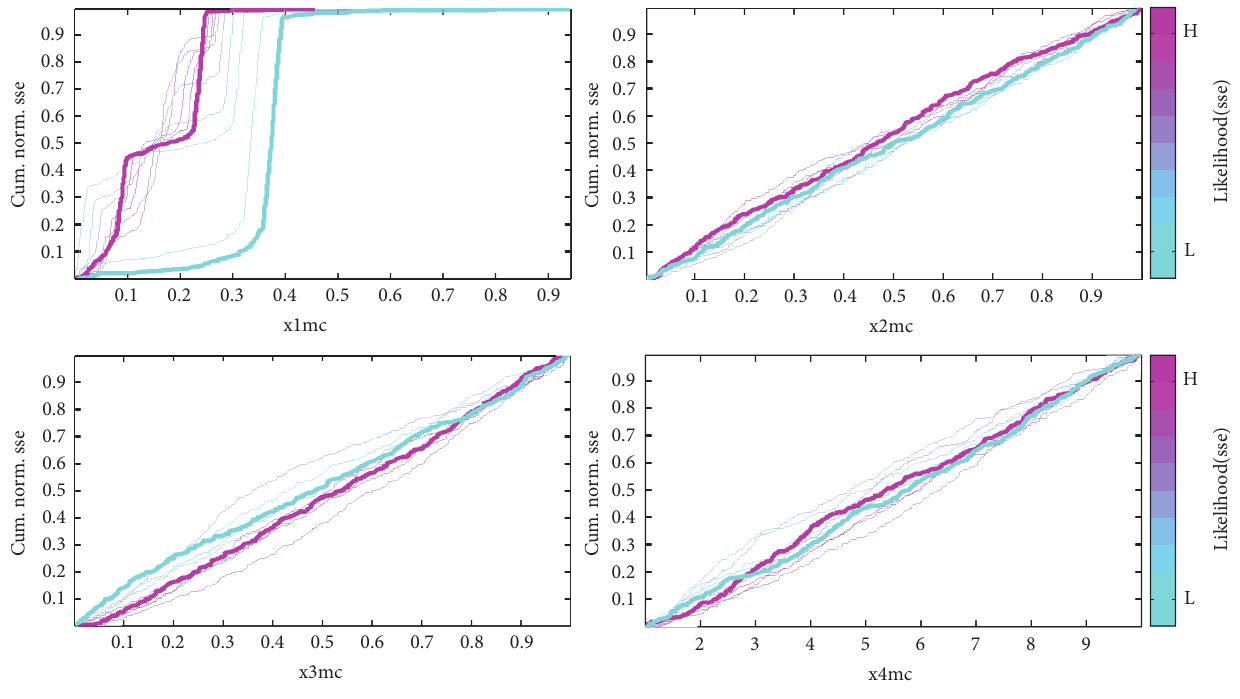
Figure 3: Regional sensitivity analysis plot. Table 2: Statistical results of 20